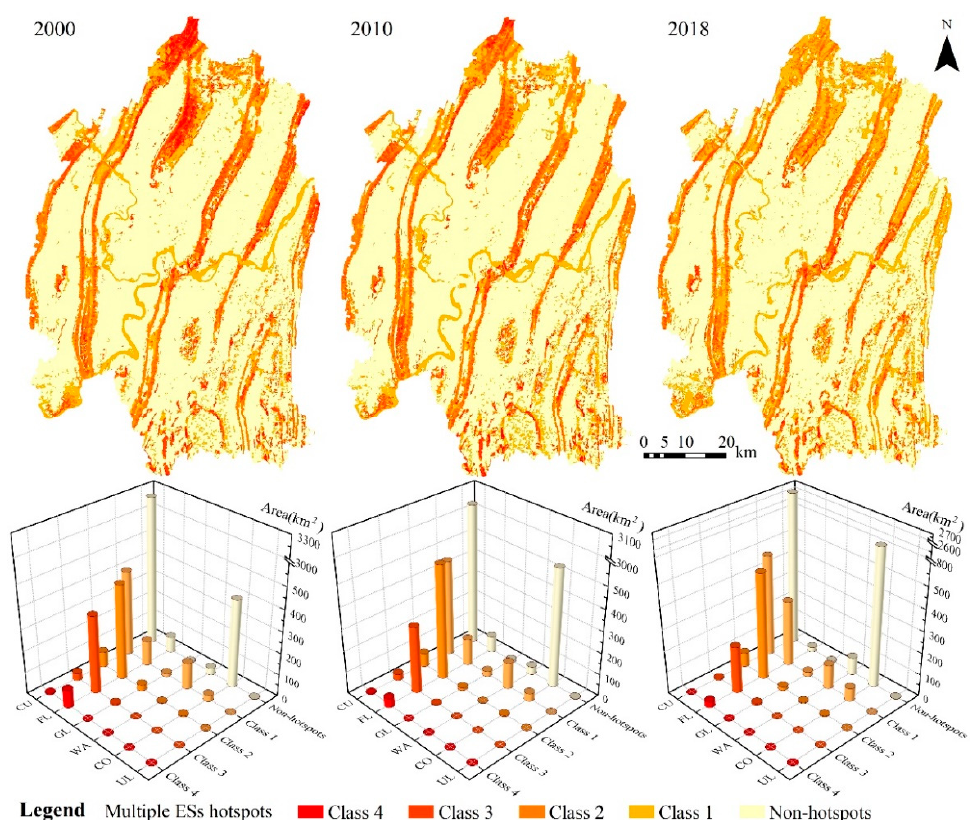
Figure 5. Spatiotemporal distributions and land use compositions of multiple ES hotspots. CU: cultivated land; FL: forestland; GL: grassland; WA: waters; CO: construction land; UL: unused land. The same is true below.